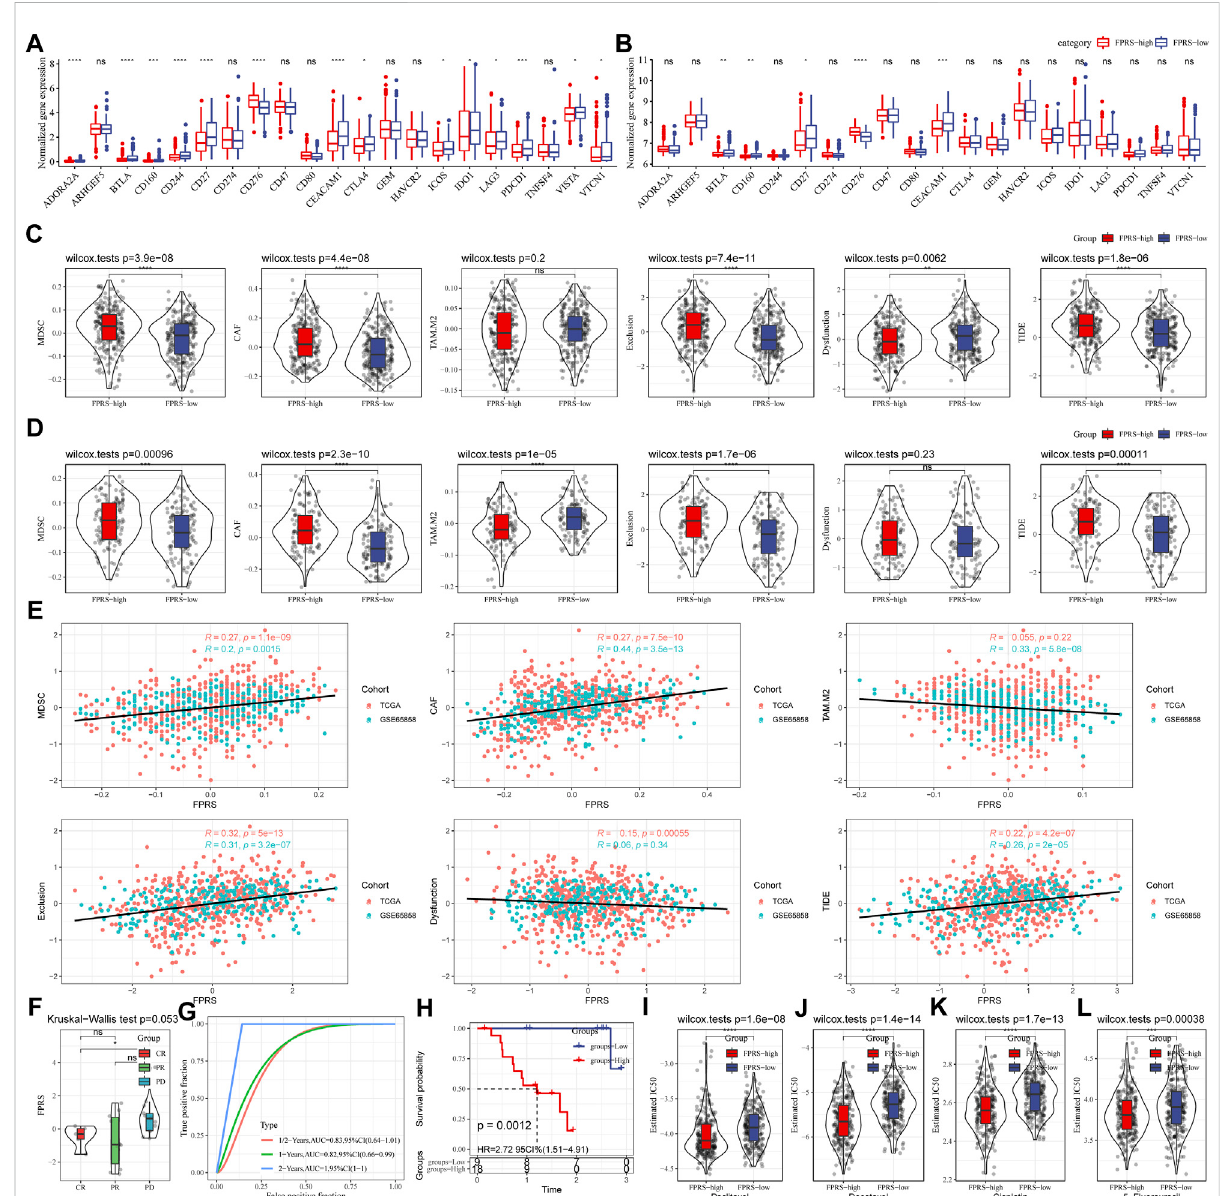
FIGURE 11 Differences in immunotherapy/chemotherapy between FPRS groups. (A) Differentially expressed immune checkpoints between different groups in the TCGA-HNSC cohort; (B) Differentially expressed immune checkpoints between different groups in the GSE65858 cohort; (C) TIDE between differentgroups inthe TCGA-HNSC cohortDifferences inanalysisresults; (D) Differences in TIDEanalysisresults betweendifferent groups in the GSE65858 cohort; (E) Correlation between TIDE scores and FPRS scores; (F) Differences in FPRS for different clinical response status to immunotherapy in the GSE78220 cohort; (G) ROC curve and AUC of FRPS classi fi cation; (H) KM survival curve distribution of FPRS; (I – L) : The box plots of the estimated IC50 for Paclitaxel, Docetaxel, Cisplatin and 5 – Fluorouracil in TCGA —